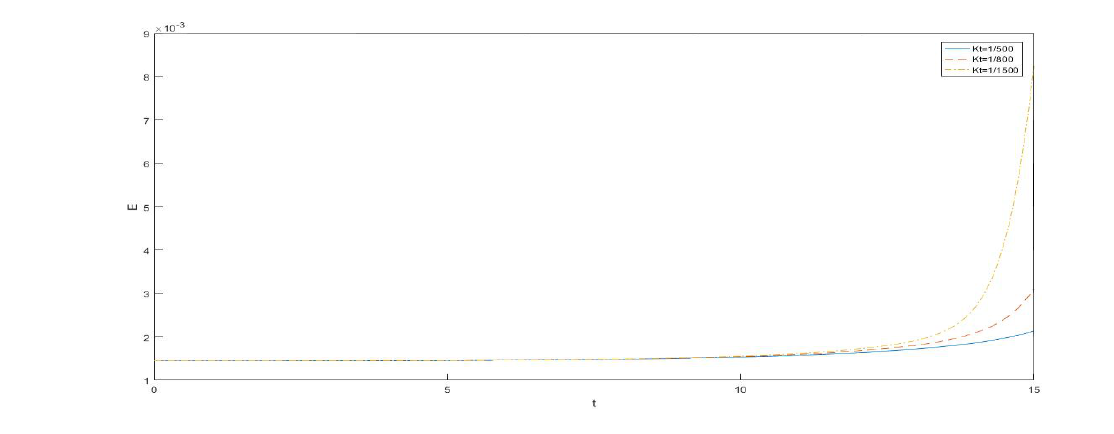
Fig. 2 the graph of the nonaxisymmetric portion ( E ) with m = 4 and α = 0.